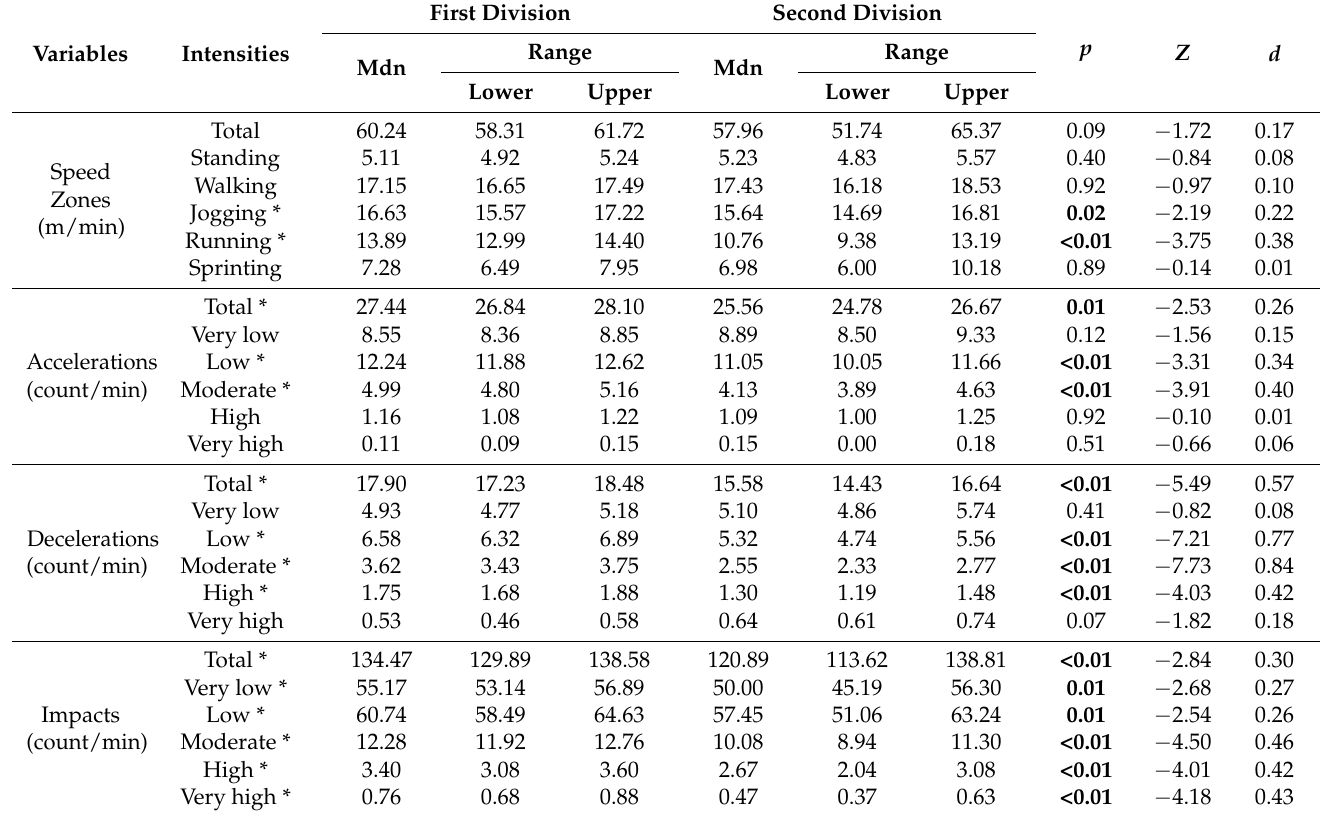
Table 4. Differences between competitive levels in external workload according to the intensity of